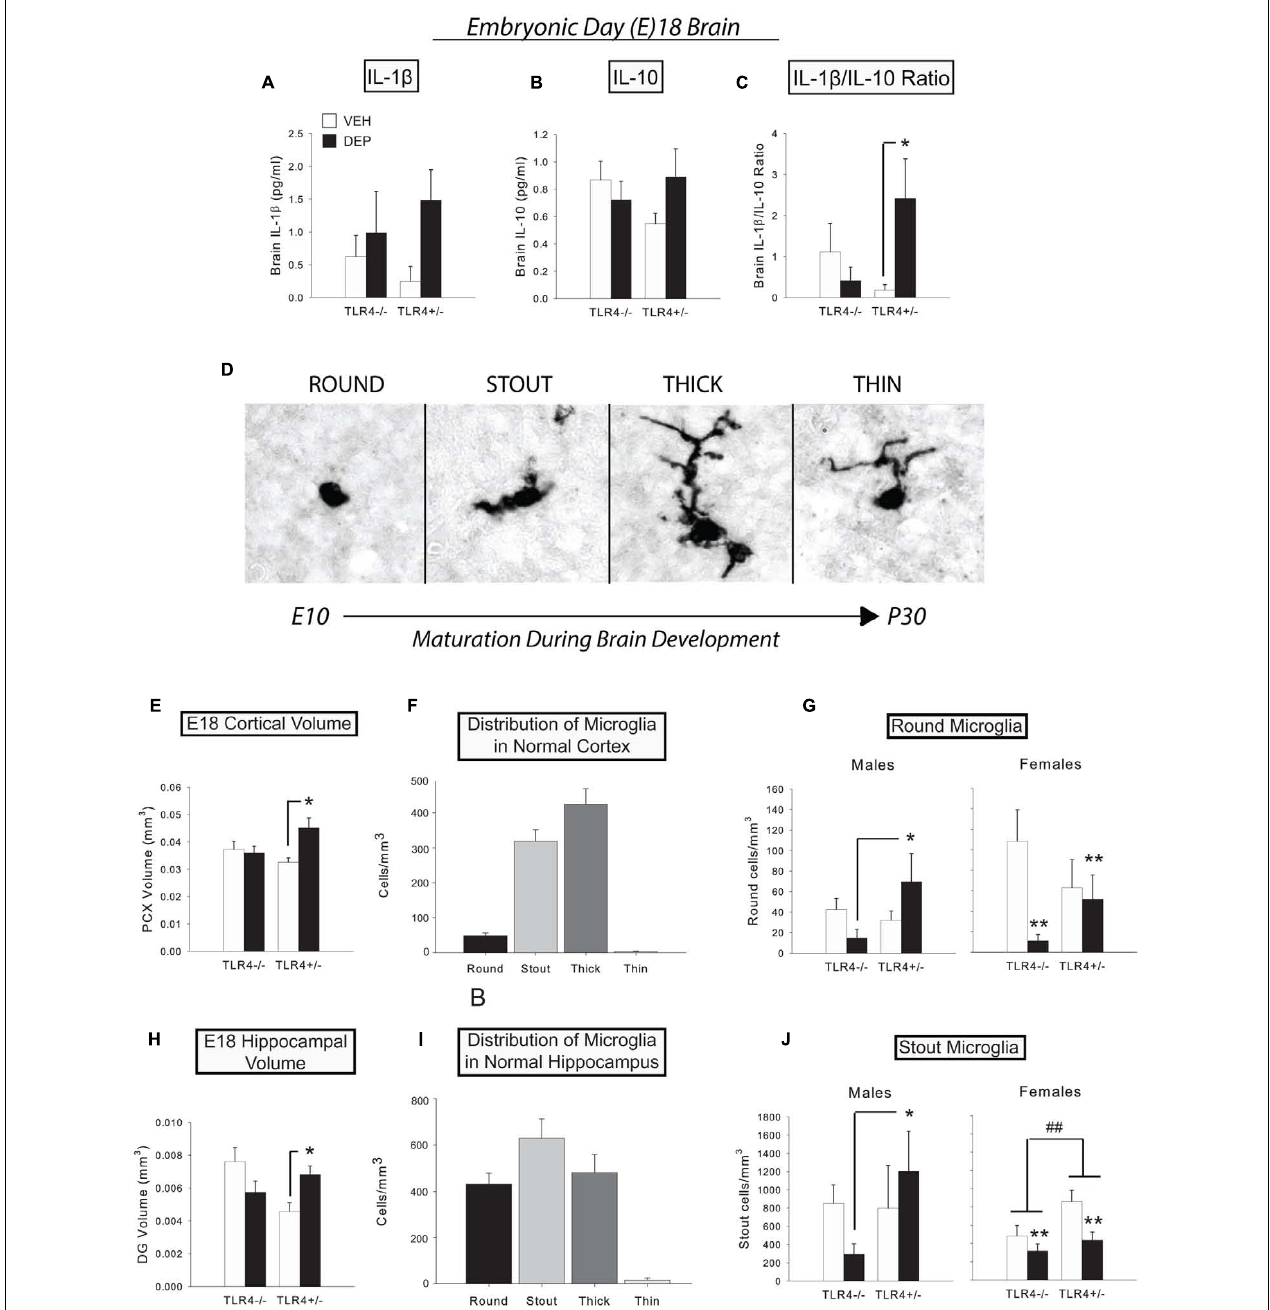
FIGURE 1 | Prenatal DEP exposure alters microglial morphology and gross regional volumes in the E18 fetal brain. (A) Levels of IL-1 β tended to be higher in E18 brains due to prenatal DEP exposure. (B) Levels of IL-10 did not significantly differ in the E18 brain. (C) The proinflammatory bias (IL-1 β /IL-10 ratio) was significantly greater in DEP TLR4 + / − E18 brains than in VEH TLR4 + / − E18 brains. (D) The four primary microglial morphological states on E18. During development, microglia possess round/amoeboid morphology initially and gradually progress to a morphology with thin, ramified processes. Photos were taken of Iba1-labeled microglia in the mouse CA1 at the 100X objective. (E) DEP TLR4 + / − animals possess a significantly larger PCX volume than VEH TLR4 + / − animals and DEP TLR4 − / − animals at E18. (F) Normal distribution of microglial morphological states in E18 PCX. (G) DEP TLR4 + / − males have significantly more round microglia in the PCX than DEP TLR4 − / − males. In contrast, VEH females have significantly more round microglia than DEP females in the PCX at E18. (H) DEP TLR4 + / − animals possess a significantly greater DG volume at E18 than VEH TLR4 + / − animals. (I) Normal distribution of microglial morphological states in E18 DG. (J) DEP TLR4 + / − males have significantly more stout microglia than DEP TLR4 − / − males in the E18 DG, whereas DEP females have significantly fewer stout microglia overall than VEH females. In addition, TLR4 + / − females have overall more stout microglia than TLR4 − / − females. Data are mean ± SEM. For A-C, n = 6–13/group (note that sexes are combined here). For E and H, n = 8–9/group (note that sexes are combined here). For (F,I) n = 33 animals/morphology. For (G,J) n = 3–5/group/sex. ∗ p < 0.05 vs. VEH TLR4 + / − or DEP TLR4 − / − ; ## p < 0.05, TLR4 + / − vs. TLR4 − / − ; ∗∗ p < 0.05, DEP vs. VEH.